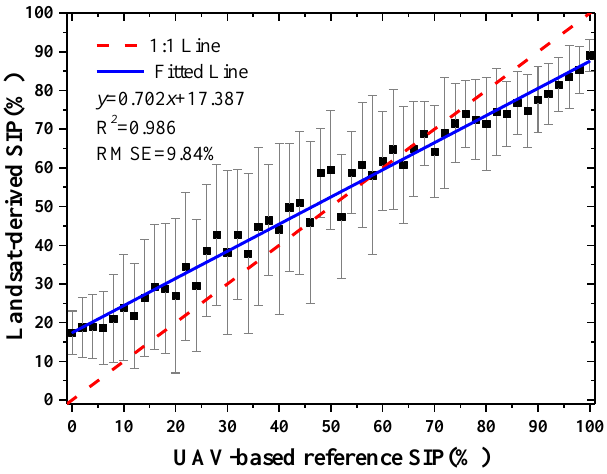
Figure 14. Comparison of the mean SIP values of RT prediction for 2013, with the mean reference SIP values within 2% bins of the 2013 reference SIP map. The mean prediction and its standard deviation in each 2% bin are shown in as a black dot and a gray bar, respectively. The red dotted and blue solid lines represent the 1:1 line and the fitted line.